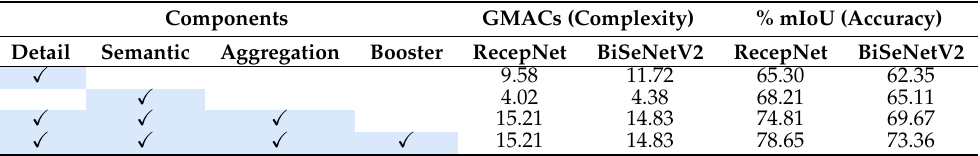
Table 11. Component performance and overall performance of RecepNet.